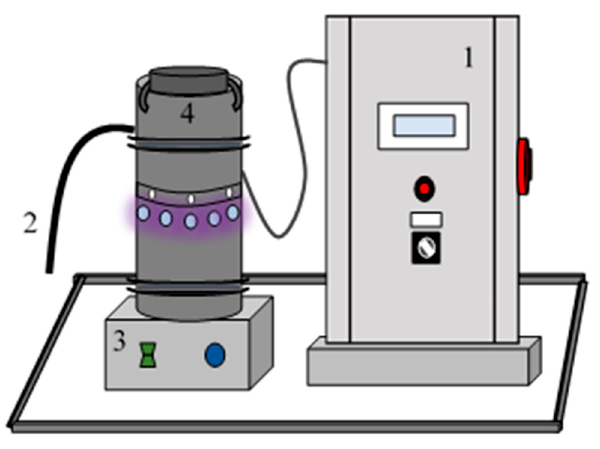
Figure 8. Experimental set up.